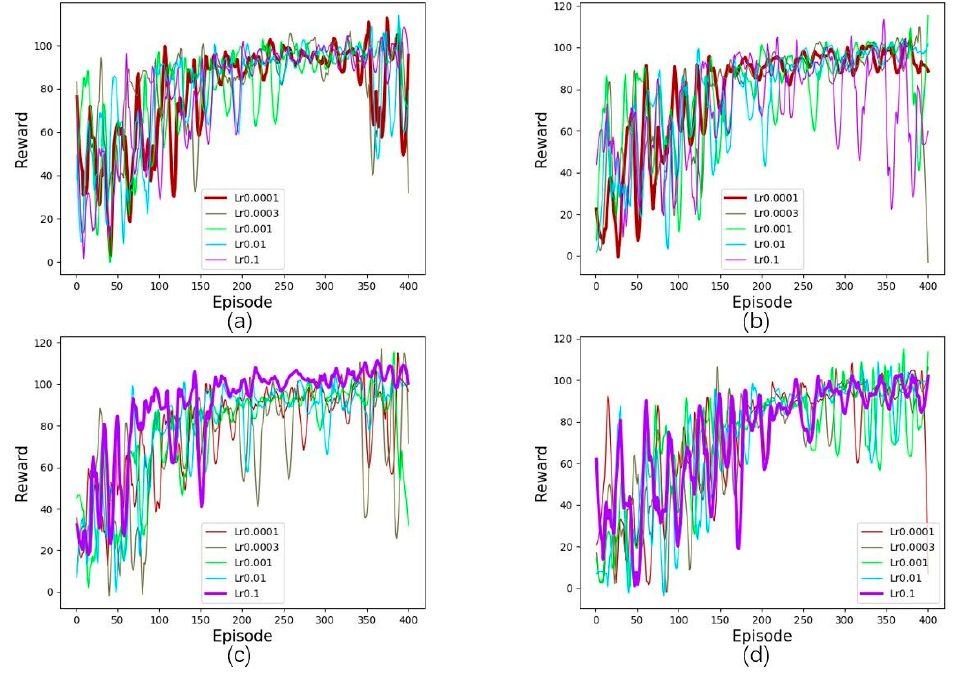
Figure 3. Effect of learning parameters: ( a ) the traffic intensity is 100%; ( b ) the traffic intensity is 75%; ( c ) the traffic intensity is 50%; ( d ) the traffic intensity is 25%.